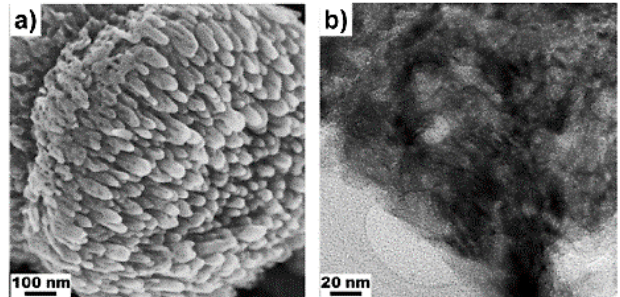
Figure 4. ( a ) SEM image of calcined TB ‐ ZnO mesocrsytal; ( b ) transmission electron microscopy (TEM)